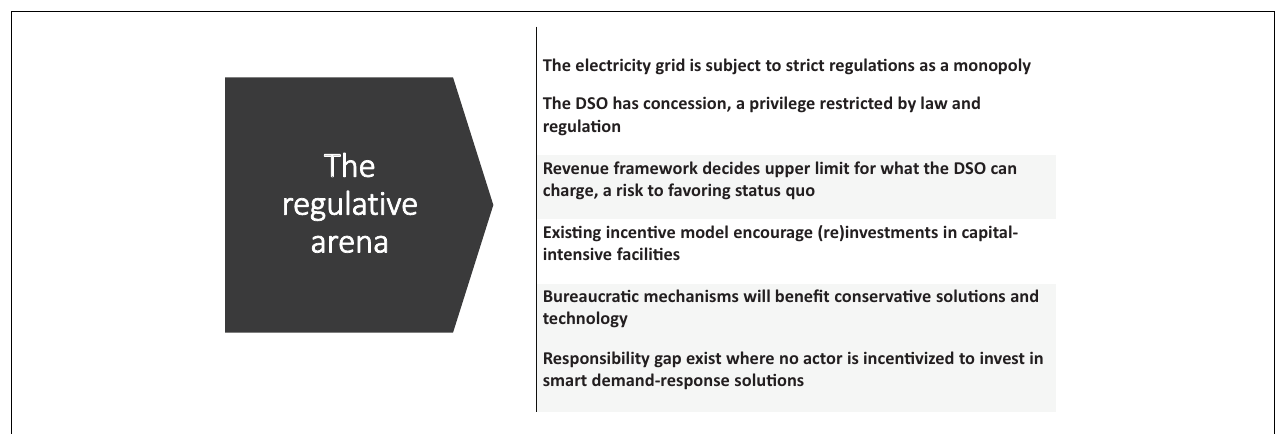
FIGURE 2 | A summary of the relevant aspects in the regulatory